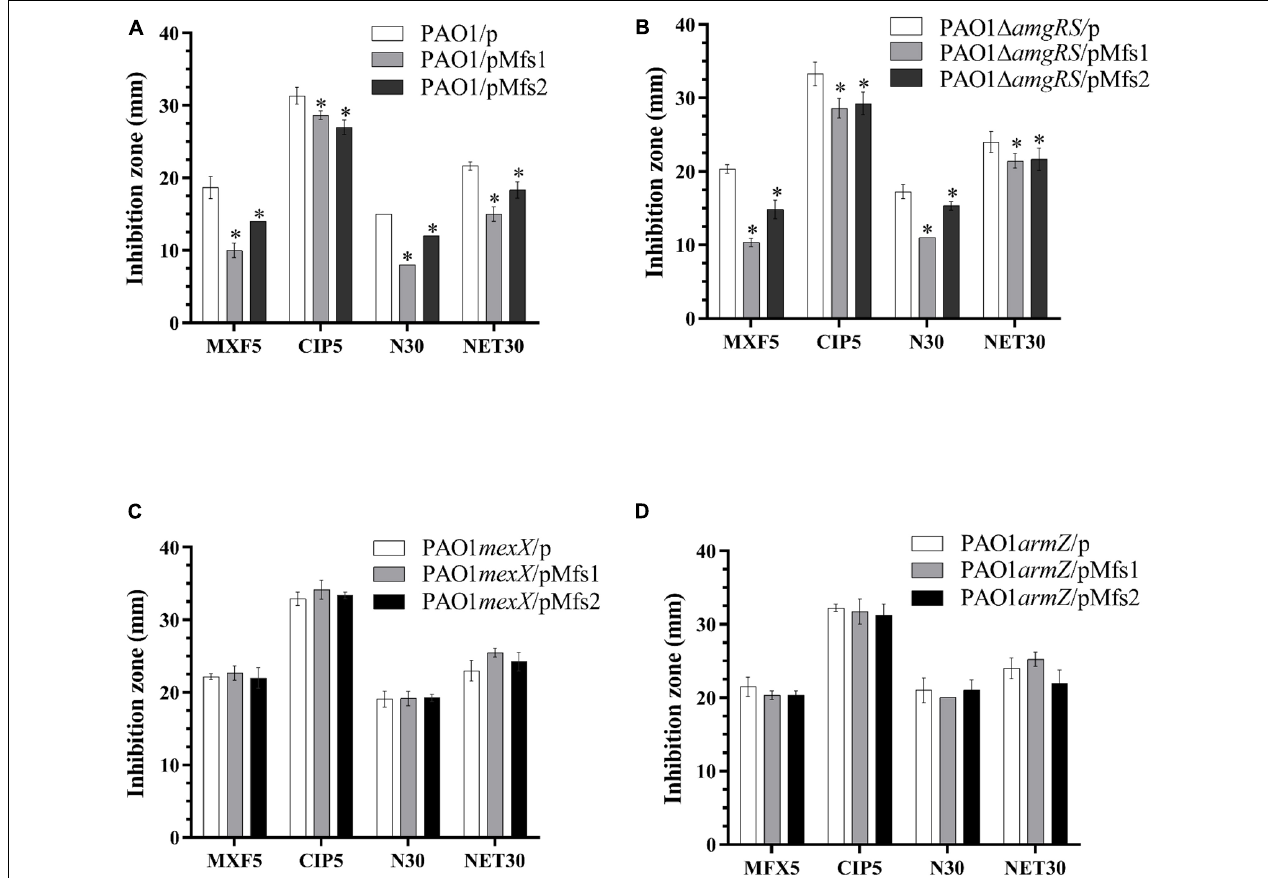
FIGURE 5 | Antibiotic susceptibility profiles of in PAO1, PAO1 (cid:49) amgRS , PAO1 mexX and PAO1 armZ carrying pMfs1 and pMfs2. (A) PAO1/p, PAO1/pMfs1. PAO1/pMfs2, (B) PAO1 (cid:49) amgRS /p, PAO1 (cid:49) amgRS /pMfs1, PAO1 (cid:49) amgRS /pMfs2, (C) PAO1 mexX /p, PAO1 mexX /pMfs1, PAO1 mexX /pMfs2, (D) PAO1 armZ /p, PAO1 armZ /pMfs1, and PAO1 armZ /pMfs2 against moxifloxacin (MFX, 5 µ g in disk), ciprofloxacin (CIP 5 µ g), neomycin (N 30 µ g), and netilmicin (NET 30 µ g) by using the Kirby-Bauer method. Data presented are means ± SD of three biological replicates. Asterisk ( ∗ ) indicates significant difference relative to PAO1/p, PAO1 (cid:49) amgRS /p, PAO1 mexX /p, and PAO1 armZ /p, respectively ( p- value <